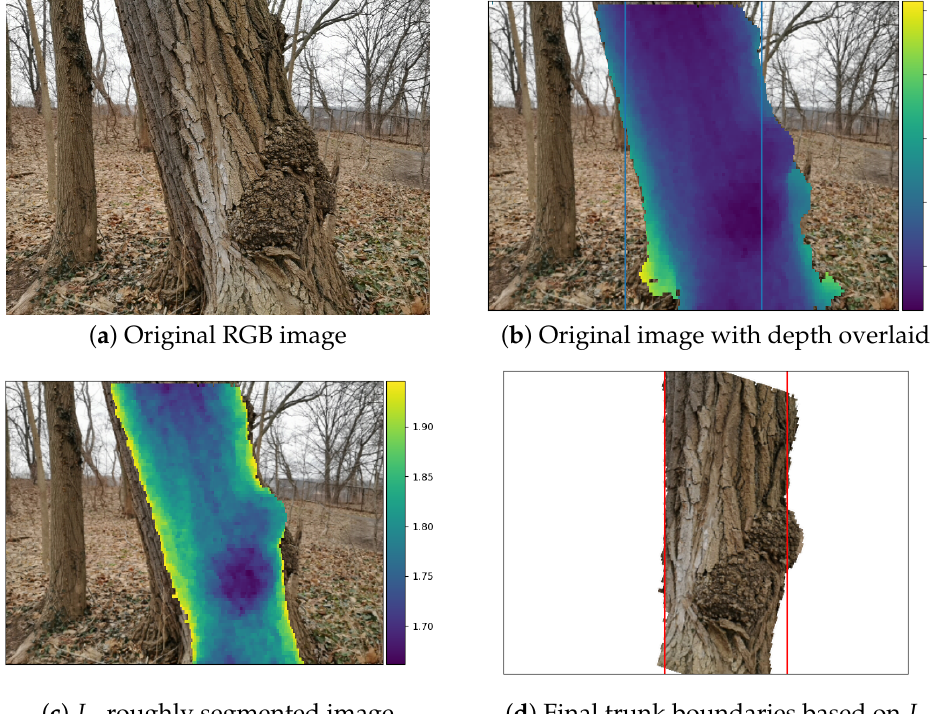
Figure A6. Processing steps for the significant outlier in the Van Cortlandt data